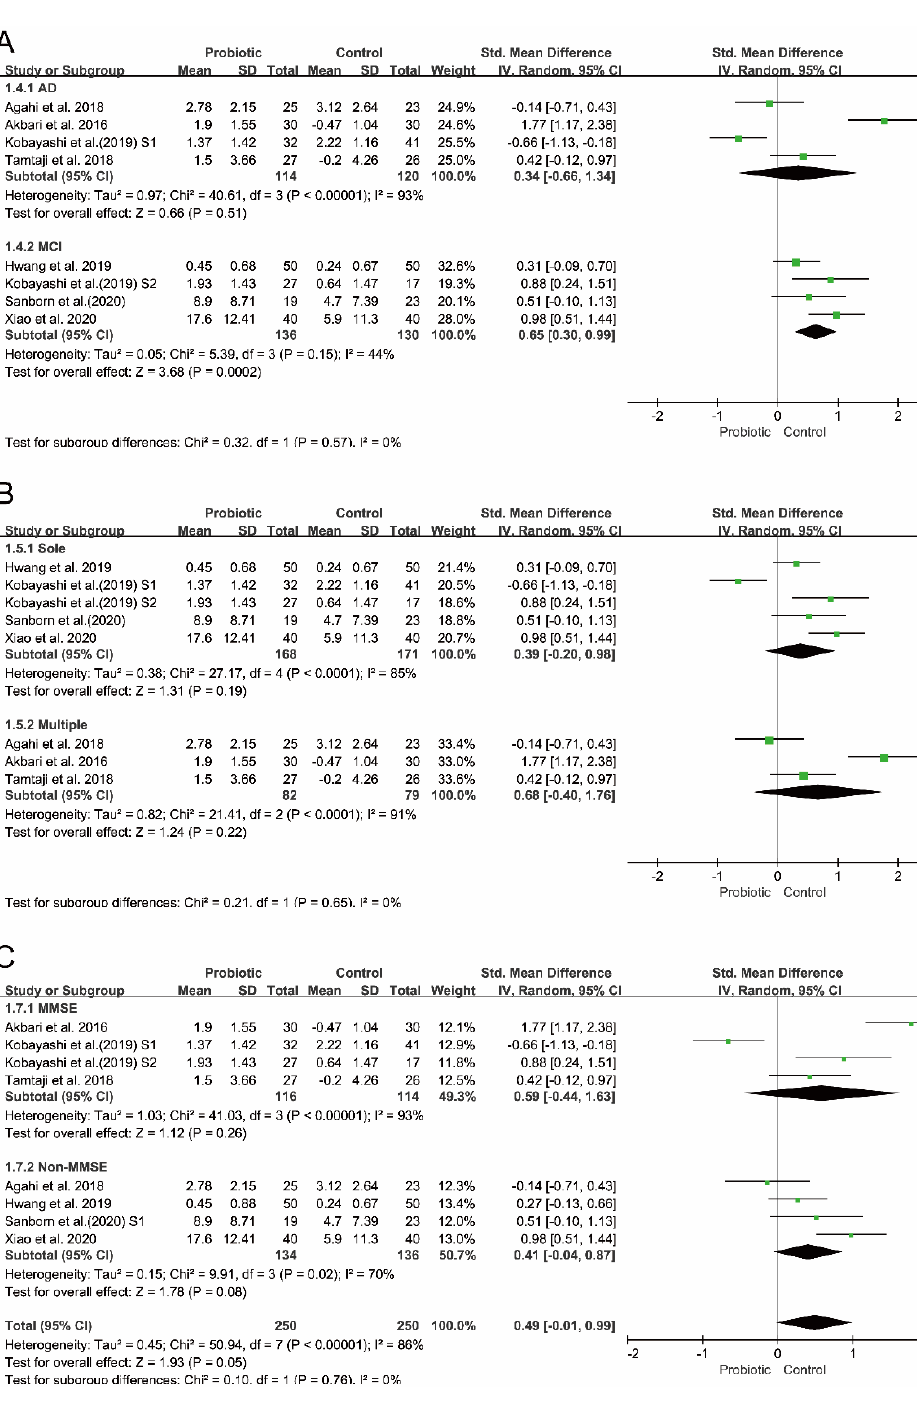
Figure 4. Subgroup analyses of the effect of probiotics on cognition. ( A ) Subgrouping by type of disease. ( B ) Subgrouping by strains of probiotics used in RCTs. ( C ) Subgrouping by cognitive rating scales.